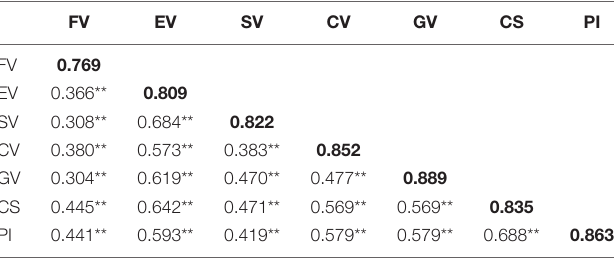
TABLE 4 | Correlation between